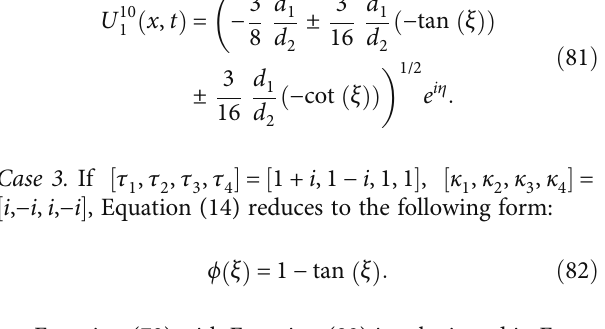
= 6, δ = δ = 0 : 6, δ = 0 : 1, w = 1, w = 0 : 01 1 2 4 3 1 2